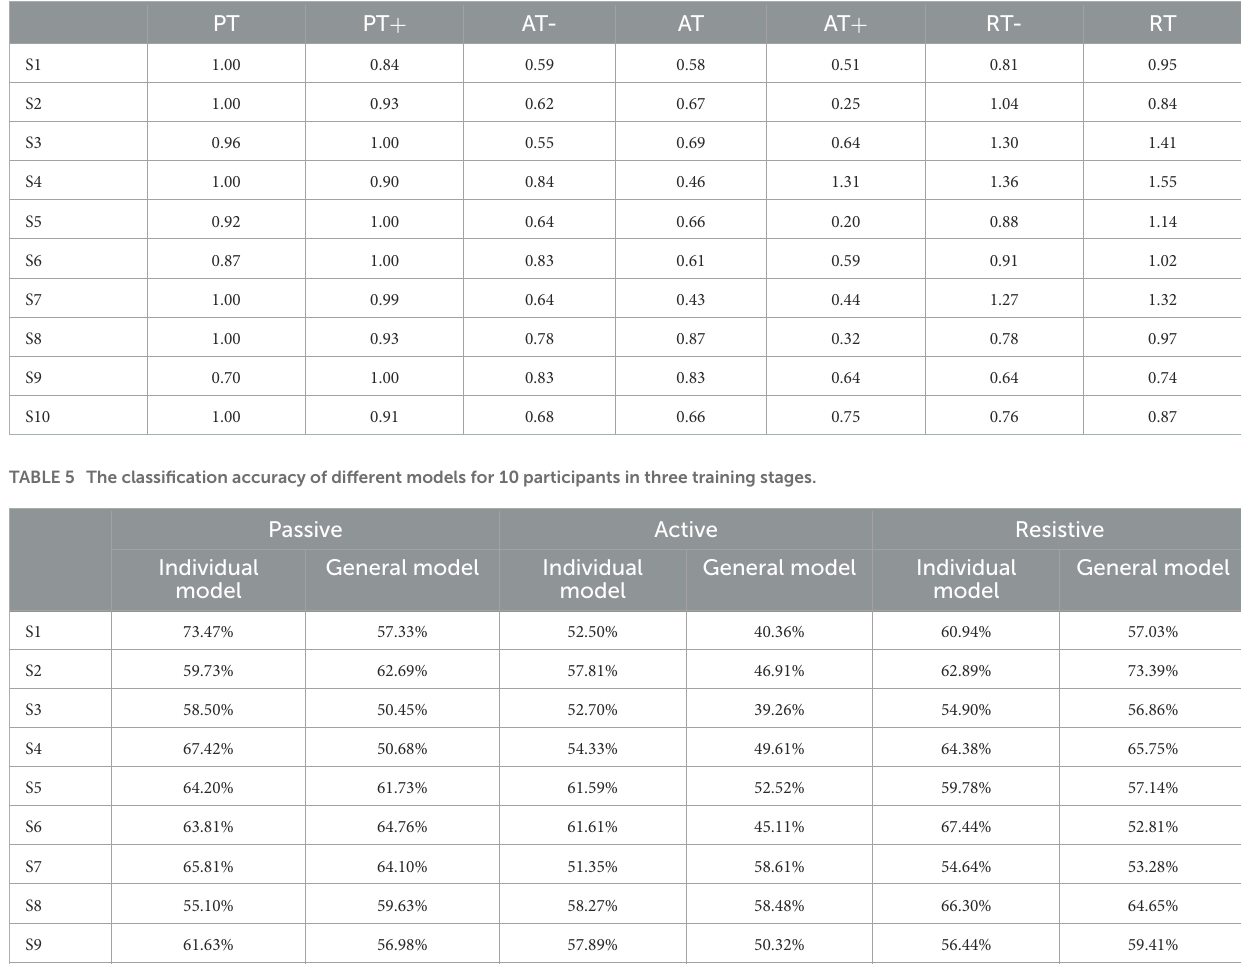
TABLE 4 Normalized mean perceived torque value of 10 participants in seven experimental protocols.